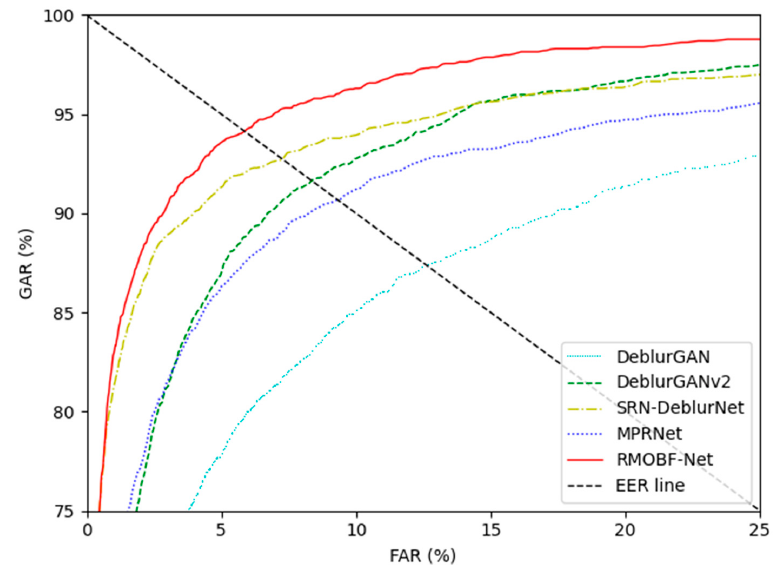
Figure 21. ROC curves of finger-vein recognition with SDU-DB for scheme 5 by various restoration methods (random motion blur and optical blur with intensity 11 × 11 (Gaussian filter size) and 11 (Gaussian filter standard deviation)).